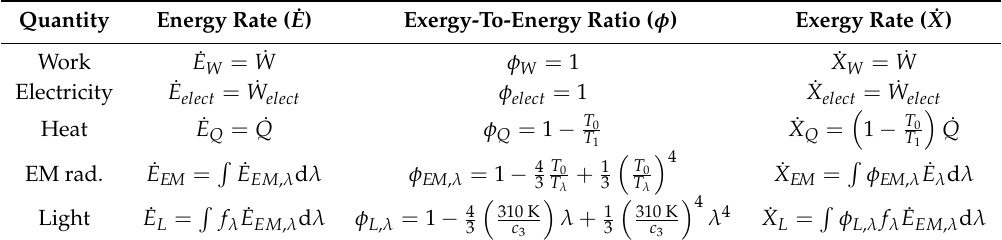
Table 1. Summary of equations for energy and exergy of work, electricity, heat, EM radiation, and light. T 0 is the environment temperature, T 1 is the temperature of heat, and T λ is the photon effective temperature (Equation (31)). Note that ˙ X = φ ˙ E on a spectral basis, if